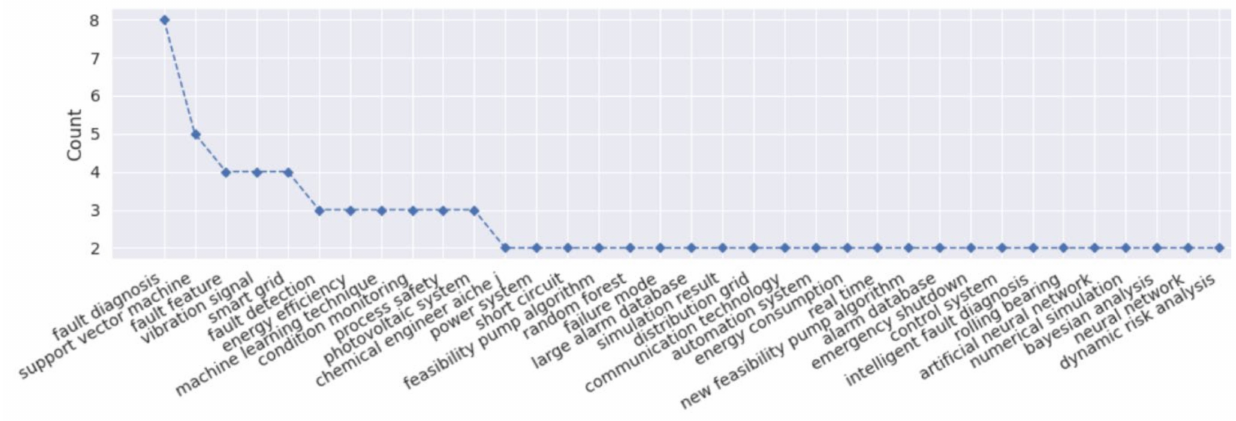
Figure 15. Top 35 most frequent keywords in scientific papers, cited in patents